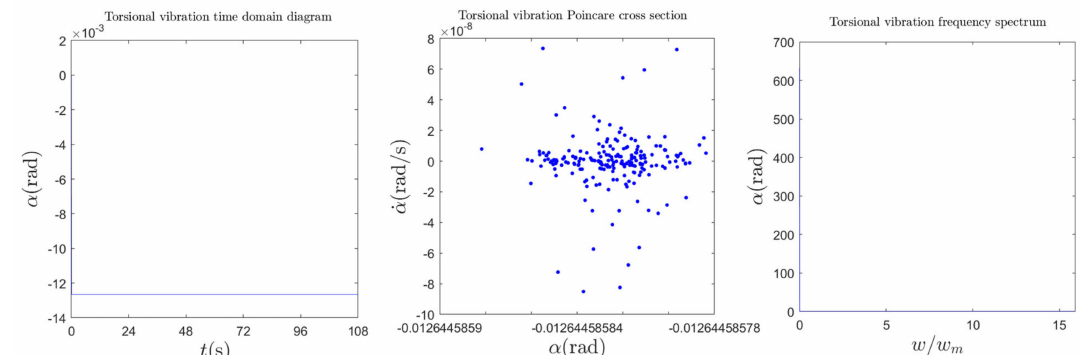
Figure 5. Dynamic behavior of torsional vibration of the